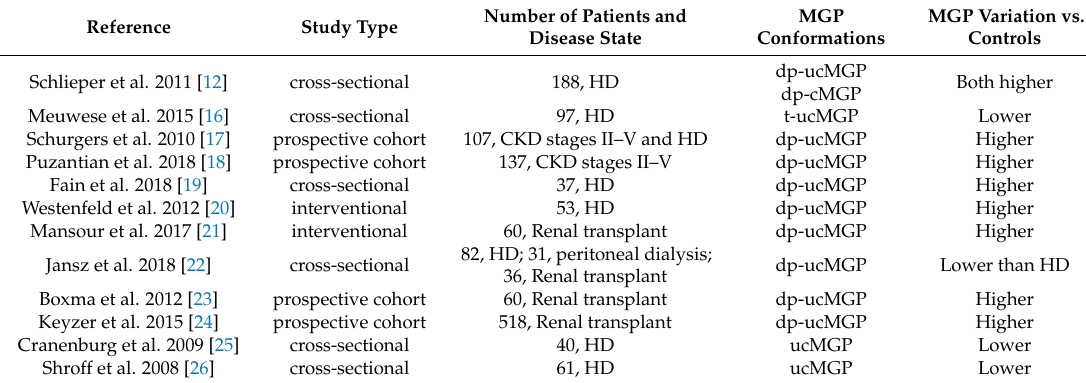
Table 2. Human studies on circulating MGP.